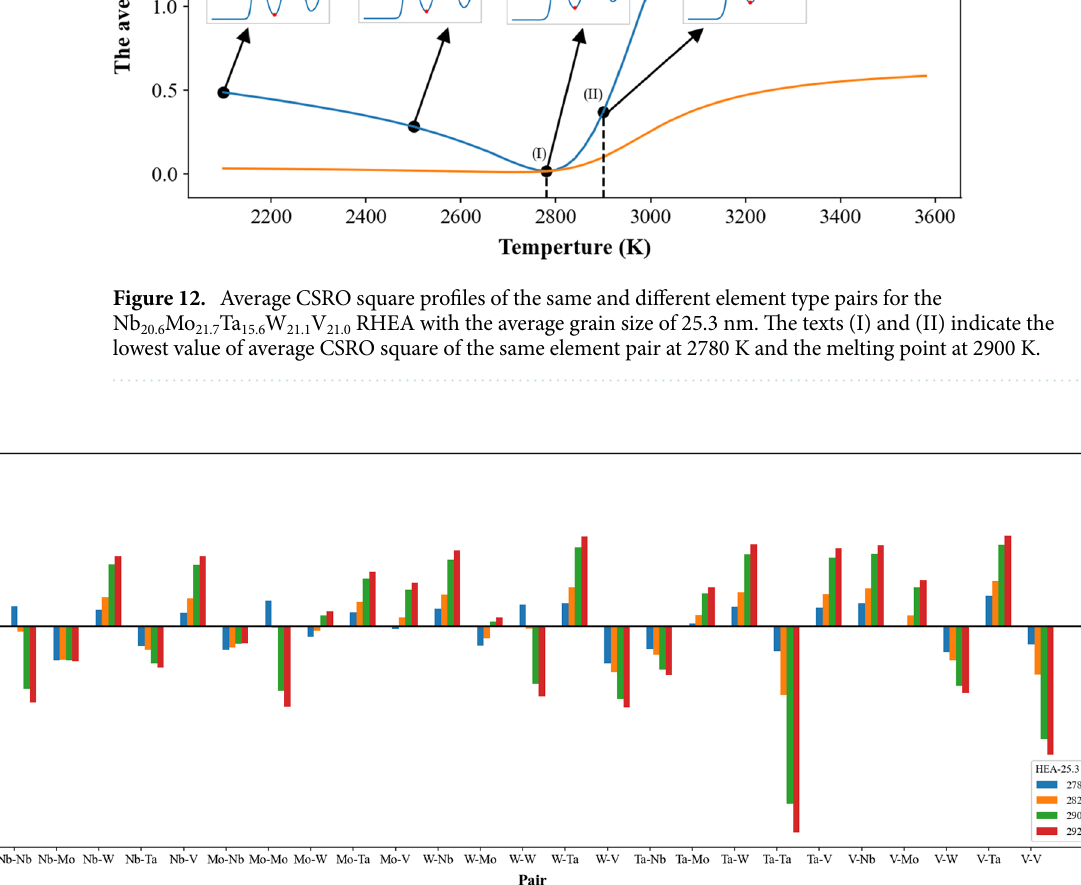
Figure 13. The CSRO distributions for the Nb 20.6 Mo 21.7 Ta 15.6 W 21.1 V 21.0 RHEA with the average grain size of 25.3 nm at four characteristic temperatures, 2780 (minimum of average CSRO square), 2820 (pre-melting temperature), 2900 (melting point), and 2920 (binding energy peak of grain atom)